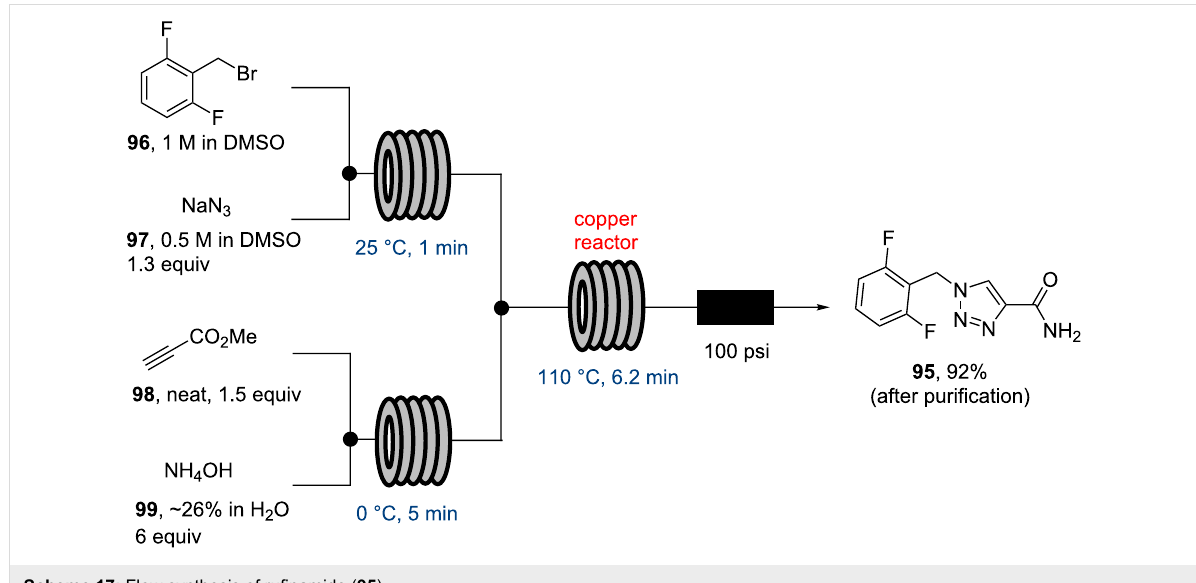
Scheme 17: Flow synthesis of rufinamide ( 95